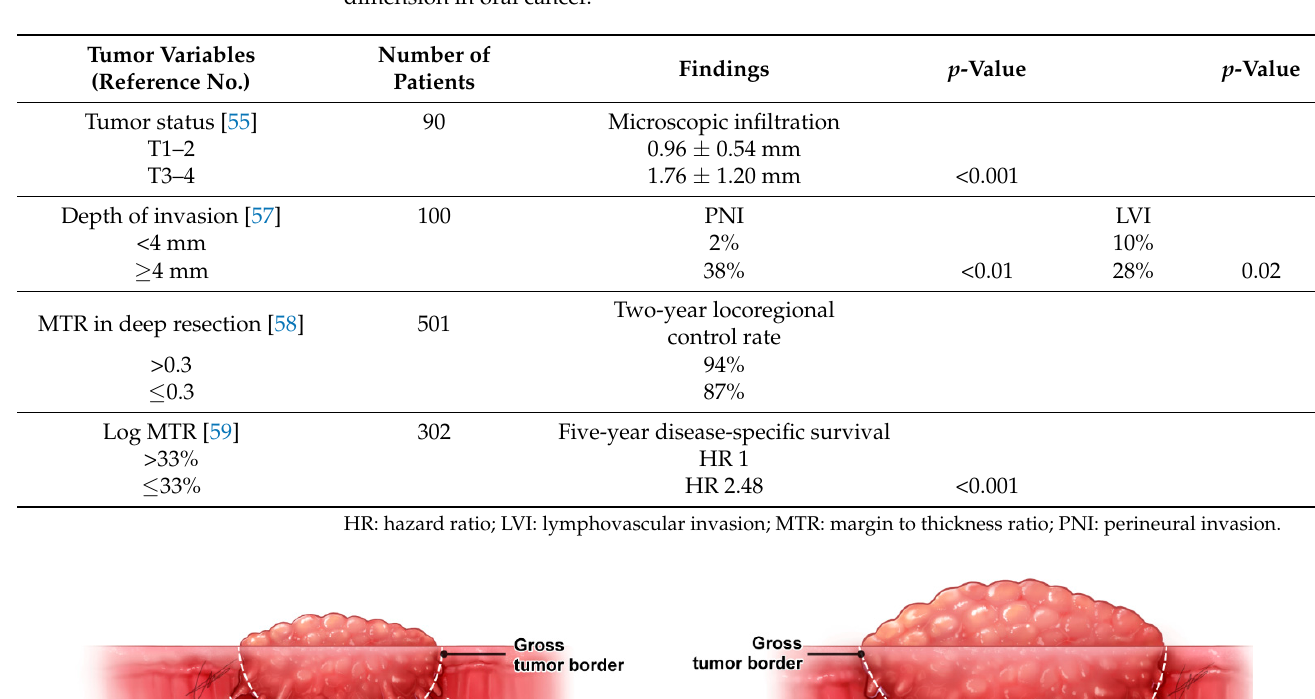
Table 2. Supporting evidence for the dynamic criteria of cut-off margin lengths according to tumor dimension in oral cancer.